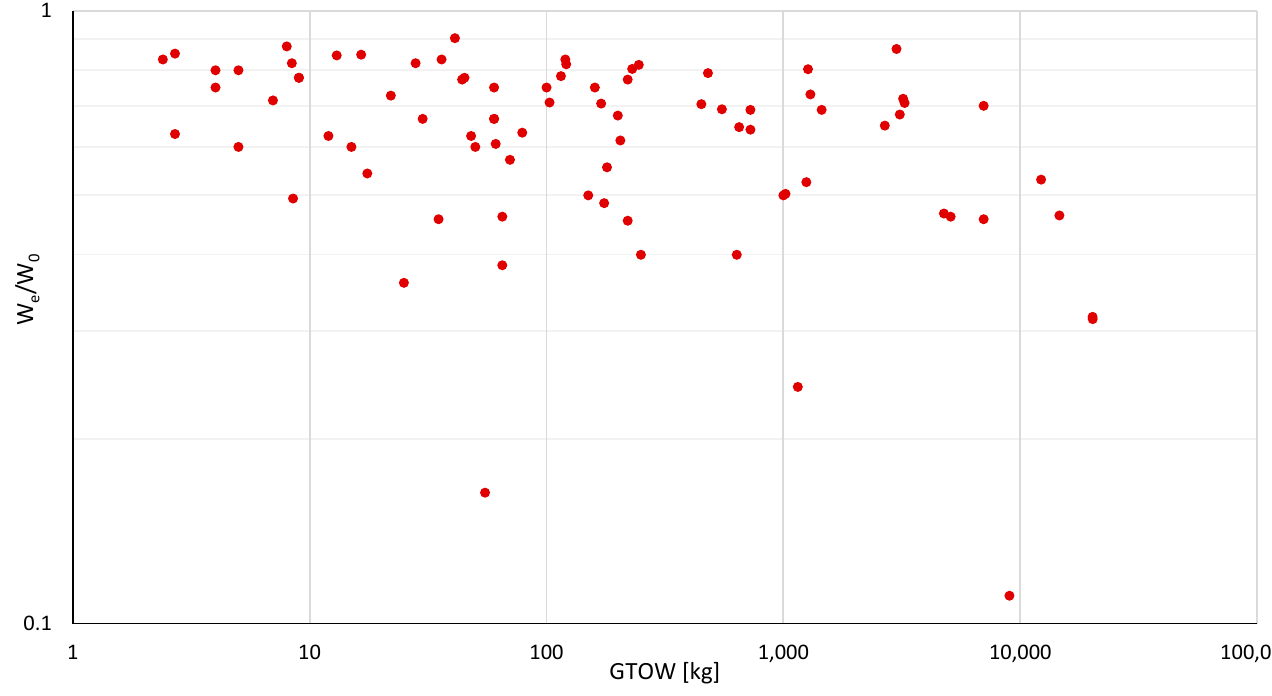
Figure 13. Empty weight as a function of GTOW with respect to region of origin.